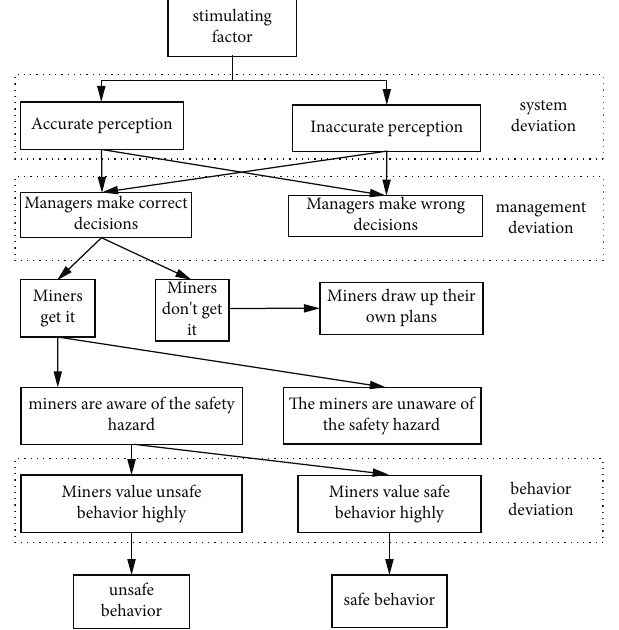
Figure 1: Occurrence mechanism model of unsafe behaviors of coal miner.